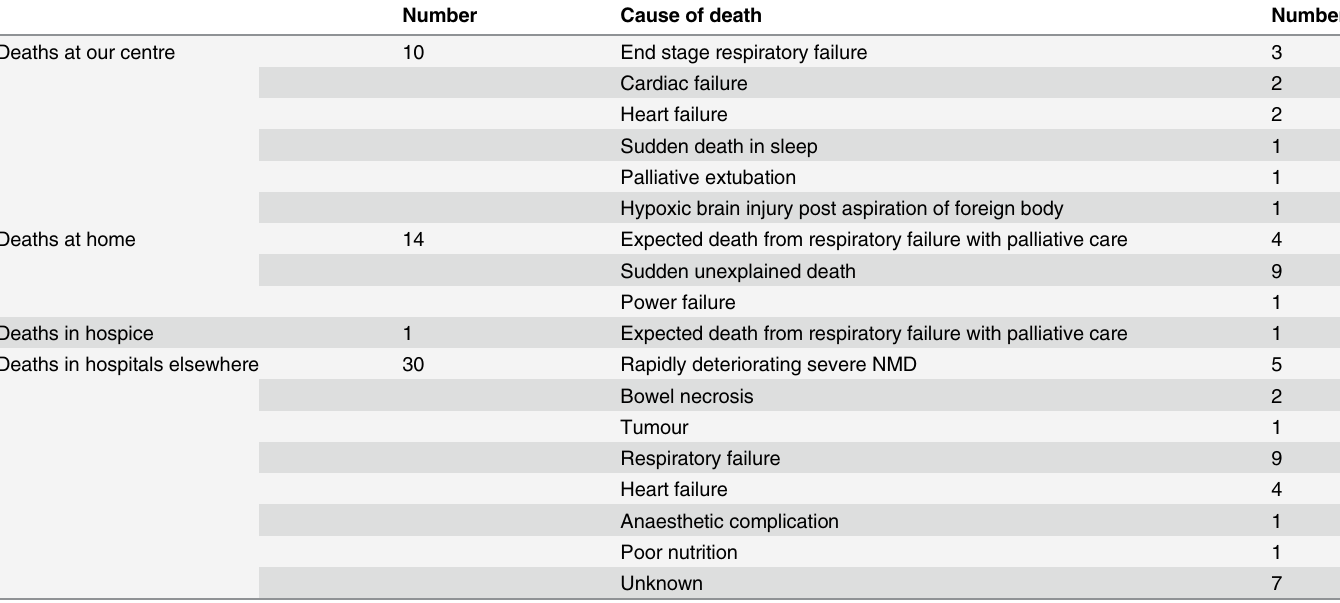
Table 5. Number of deaths by location along with cause of death.